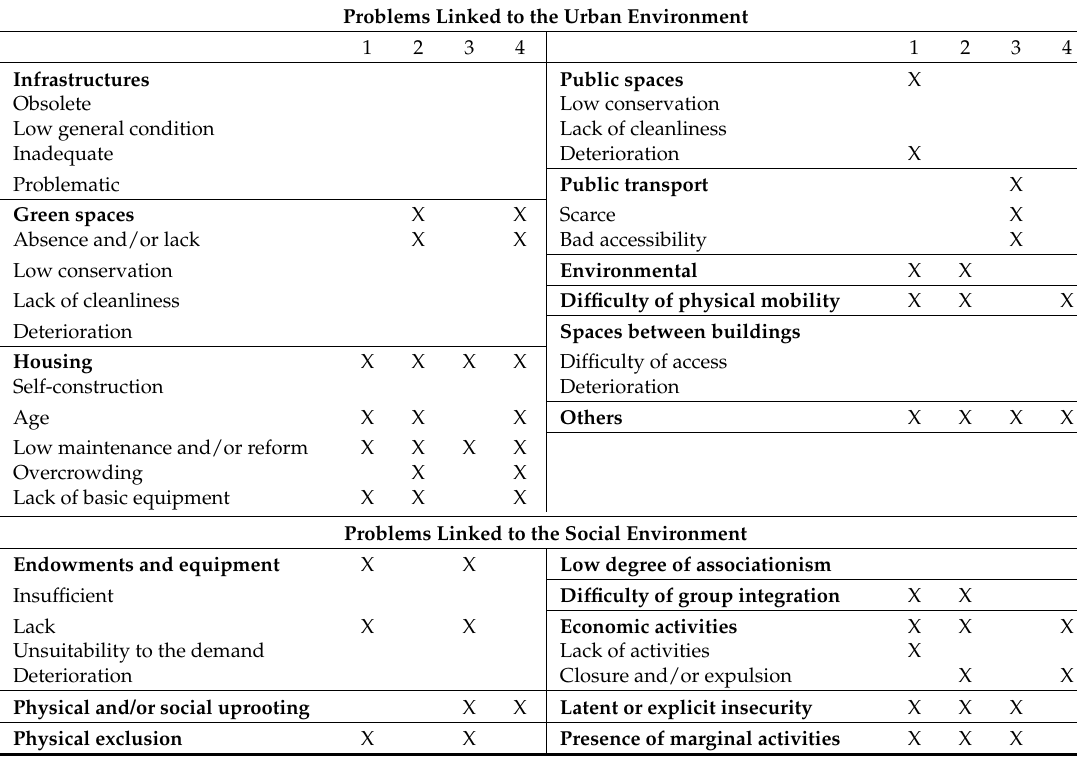
Table 1. Indicators used in qualitative research (X means that the problem exists). (1: Trinitat Nova; 2: El Raval; 3: La Marina del Prat Vermell; 4: La